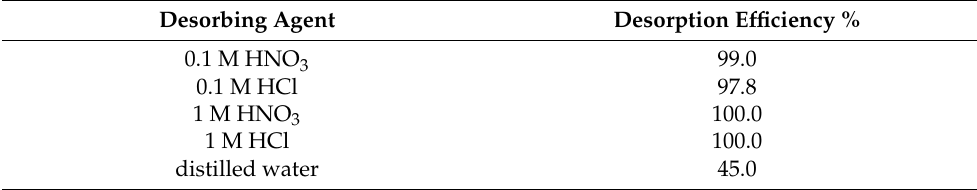
Table 6. The desorption efficiency of Mn(II) from ZH using different desorbing agents. Desorbing